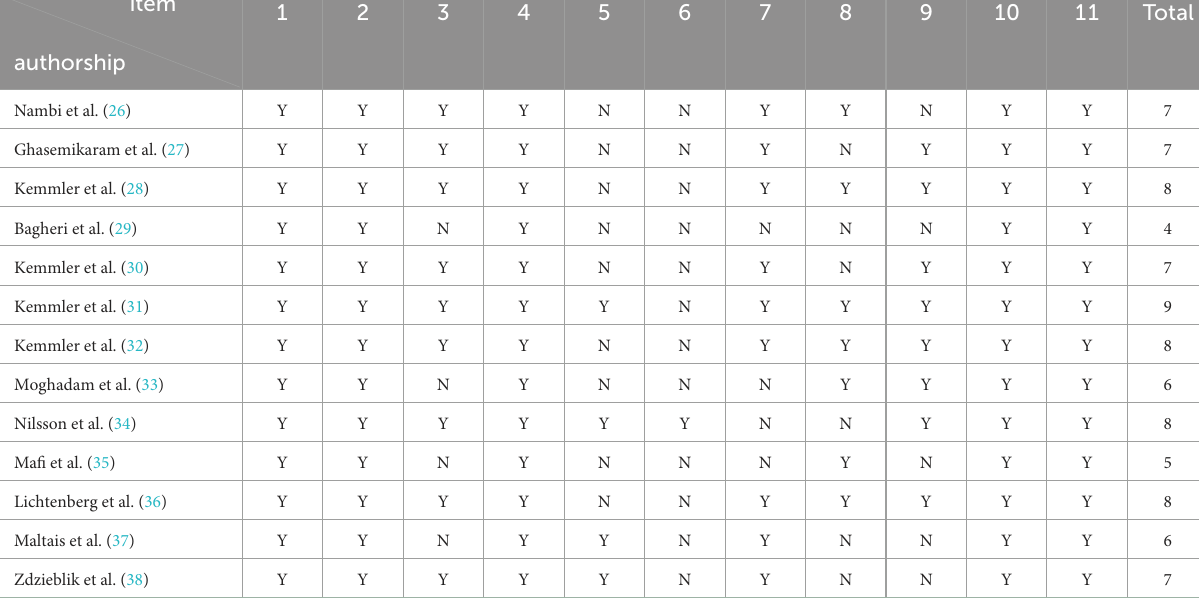
TABLE 1 Methodological quality of the articles